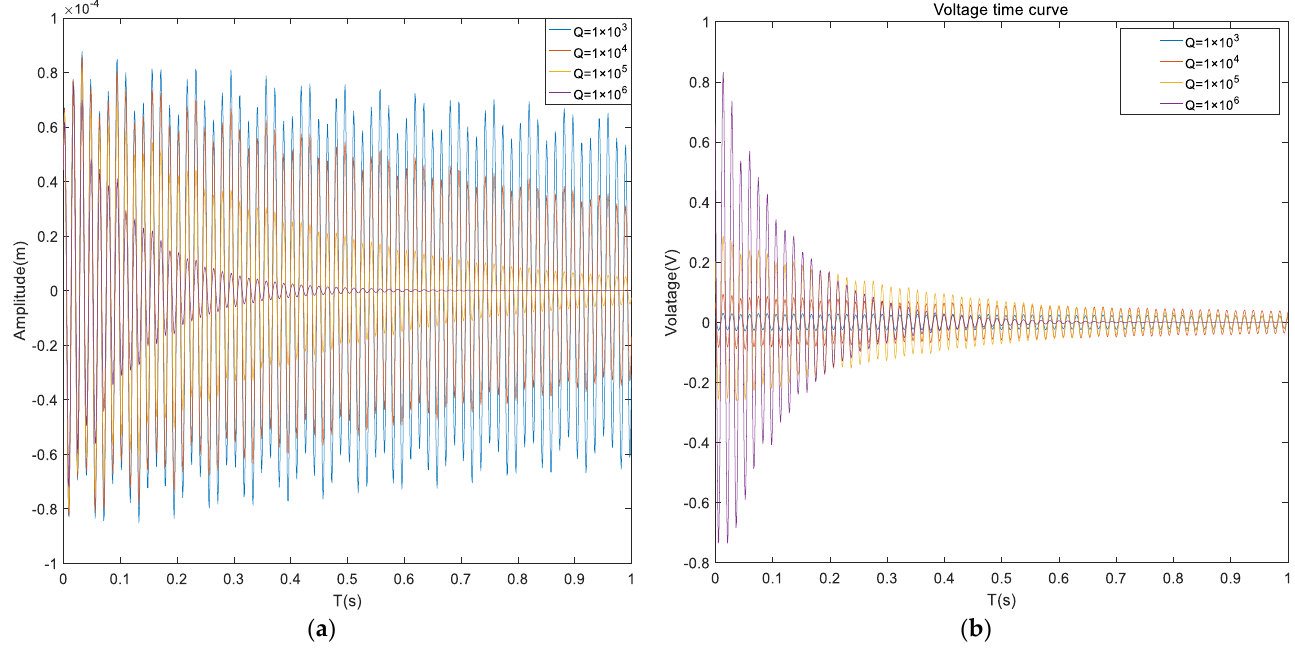
Figure 9. Comparison of system characteristics with different Q matrix coefficients. ( a ) Composite sandwich plates displacement time response; ( b ) Composite sandwich panel voltage-time curve.